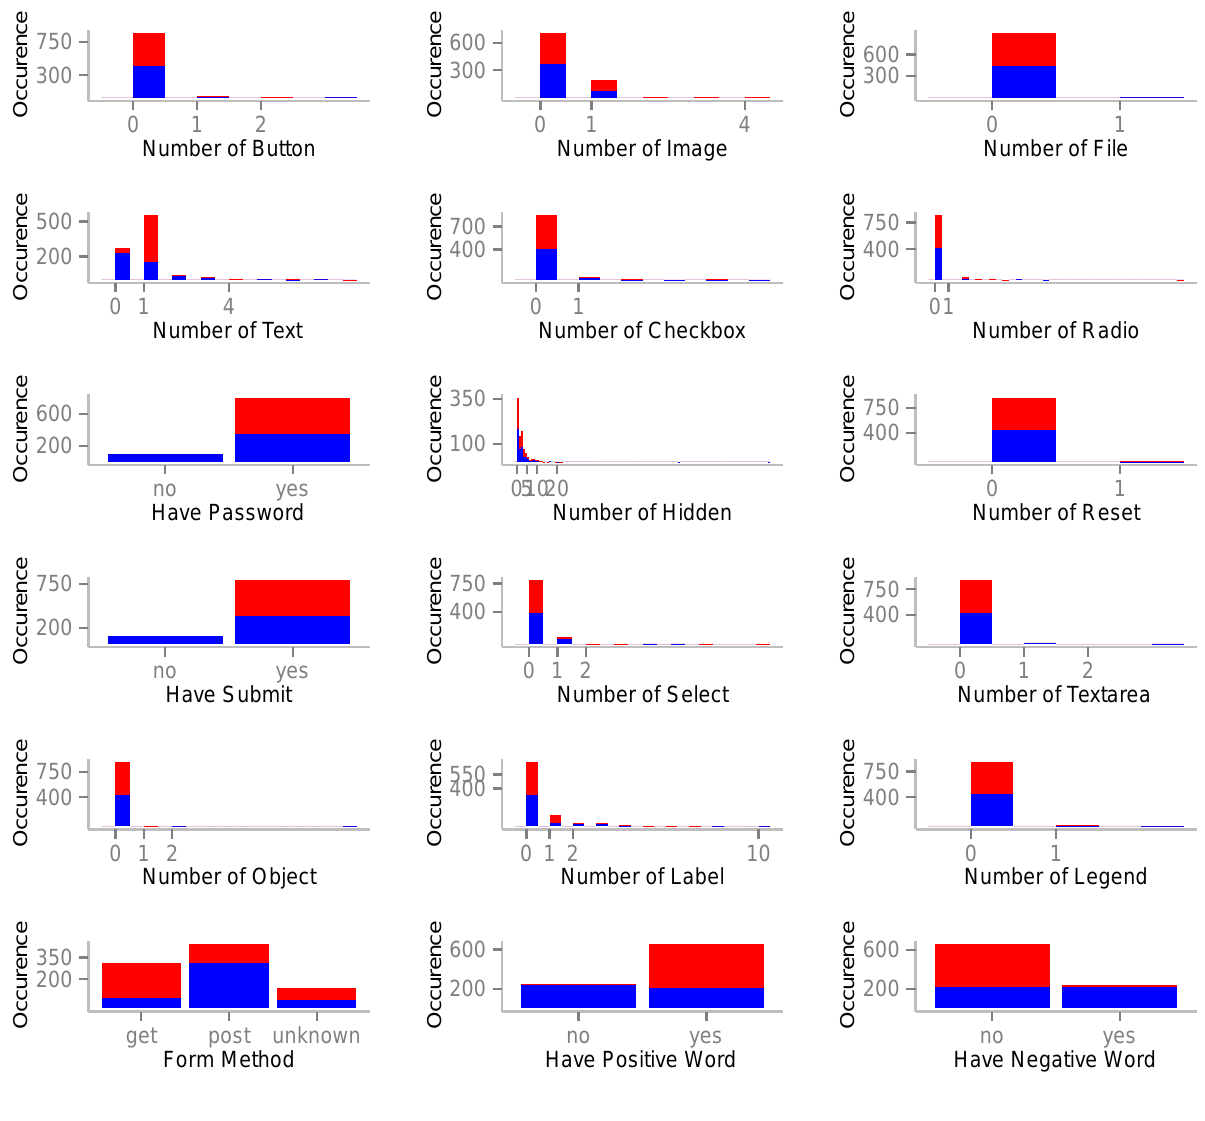
Figure 3. Feature distributions in HTML